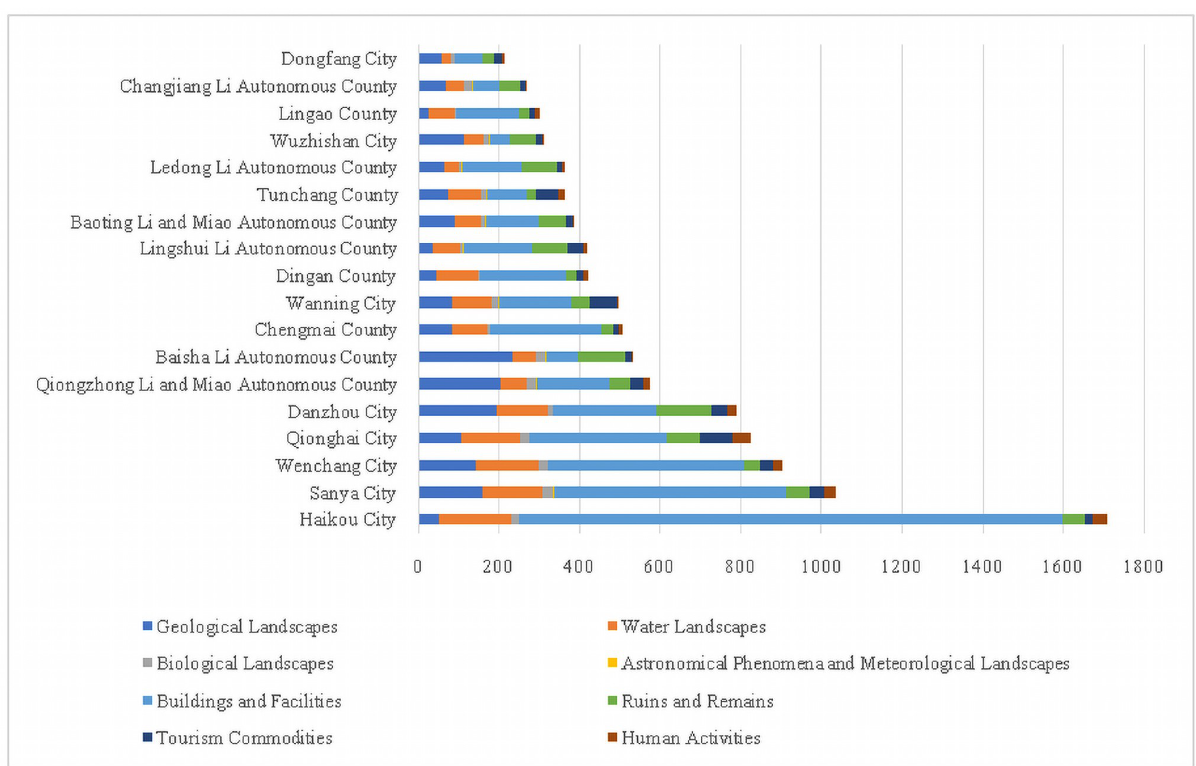
Fig 2. The quantities and structural of tourism resources at a regional scale on Hainan Island.